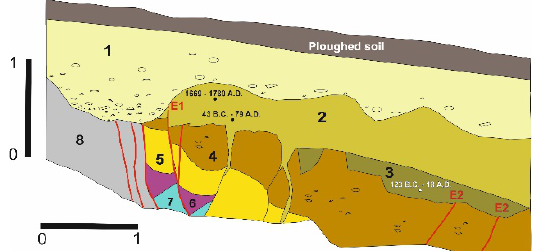
Fig. 5: Trench A. View and simplified log of the E trench wall. Black dots indicate dated radiocarbon samples. Stratigraphic units and deformation zones are described in the